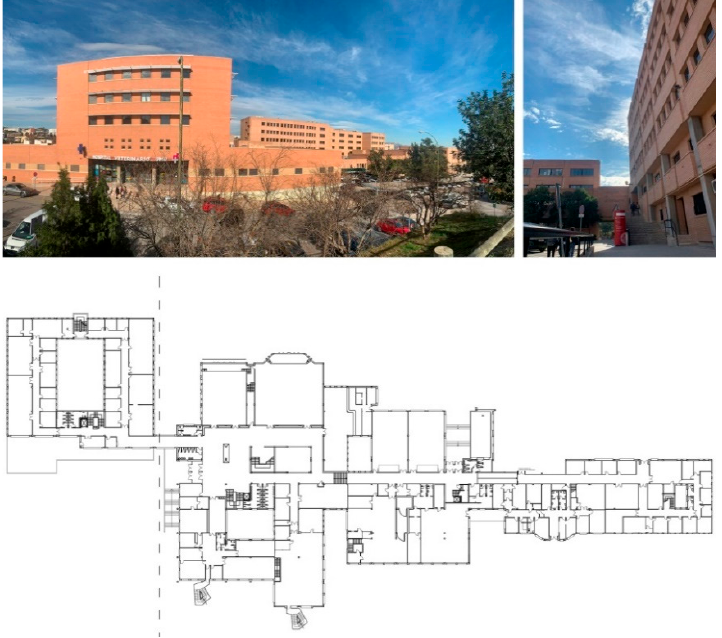
Figure 16. Photos and ground floor of the FVM, University of Murcia. Photos: Authors. Drawing: University of Murcia Technical Division.